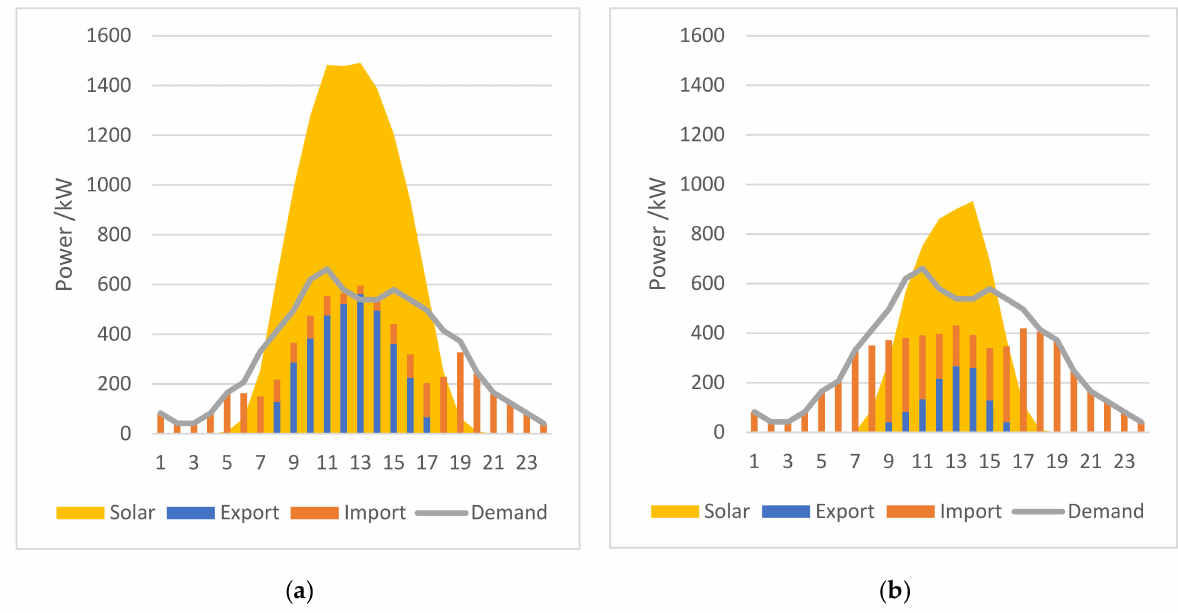
Figure 15. The Drive-4-Data hourly average values per day of PV output, energy imports, energy exports, and demand. ( a ) Summer. ( b )